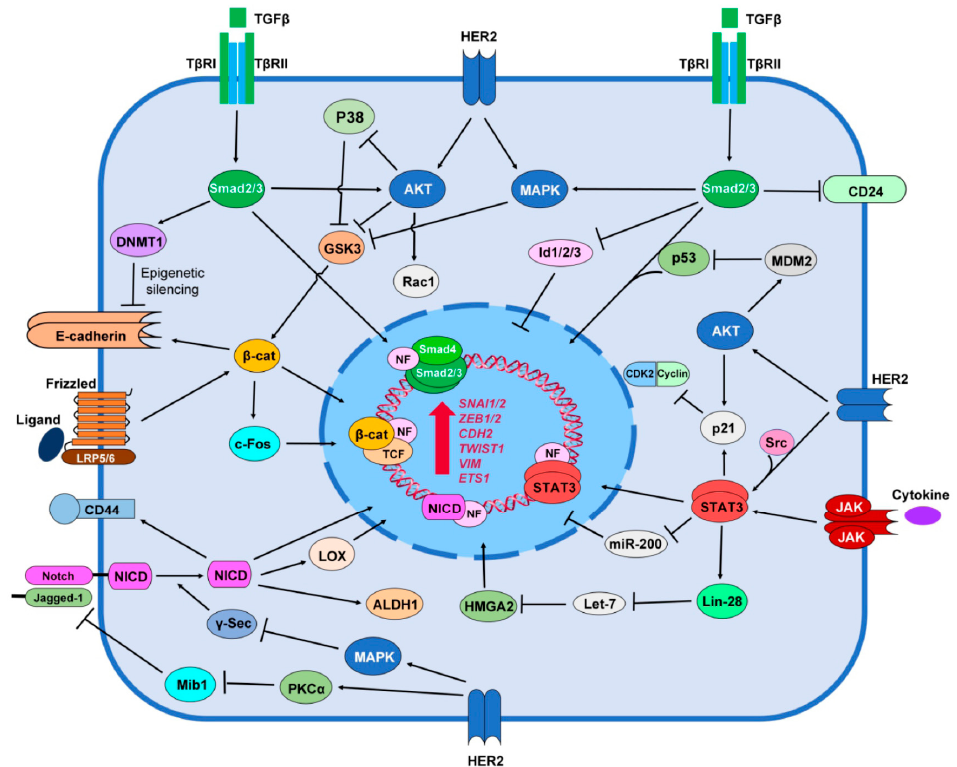
Figure 1. Crosstalk between HER2 and BC stemness signaling pathways. Active TGF- β /Smad